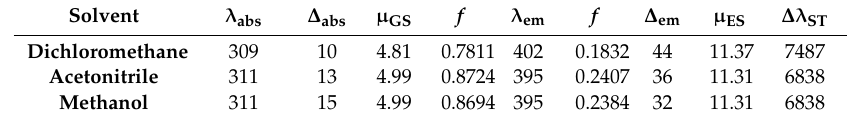
Figure 8. Geometries in the ground ( a ) and the first excited state ( b ) of spiropyran 7 obtained at PBE1PBE / cc-pVDZ level of theory in dichloromethane. Table 3. Calculated photophysical proprieties of spiropyran 7 at PBE1PBE / jun-cc-pVTZ level of theory.